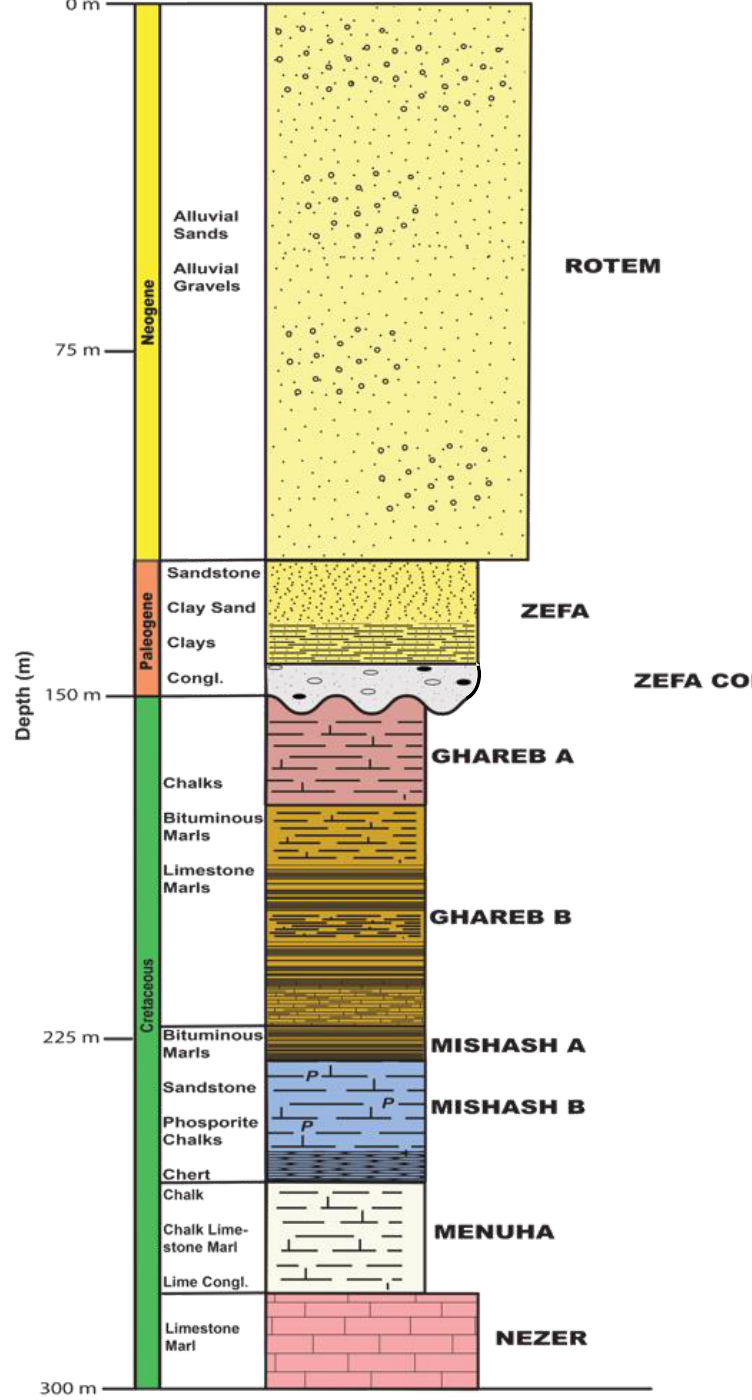
Figure A2. Sketch of an idealized columnar stratigraphic section of the Yamin Plain subsurface geology, NE Negev Desert, Israel. Based on core sample descriptions and cuttings from borehole YP-16 (c.f., Figure A1). Samples studied are Campanian (Mishash Fm.) to Miocene (Hazeva Group) in age. Modified from Bussod et al. [1].